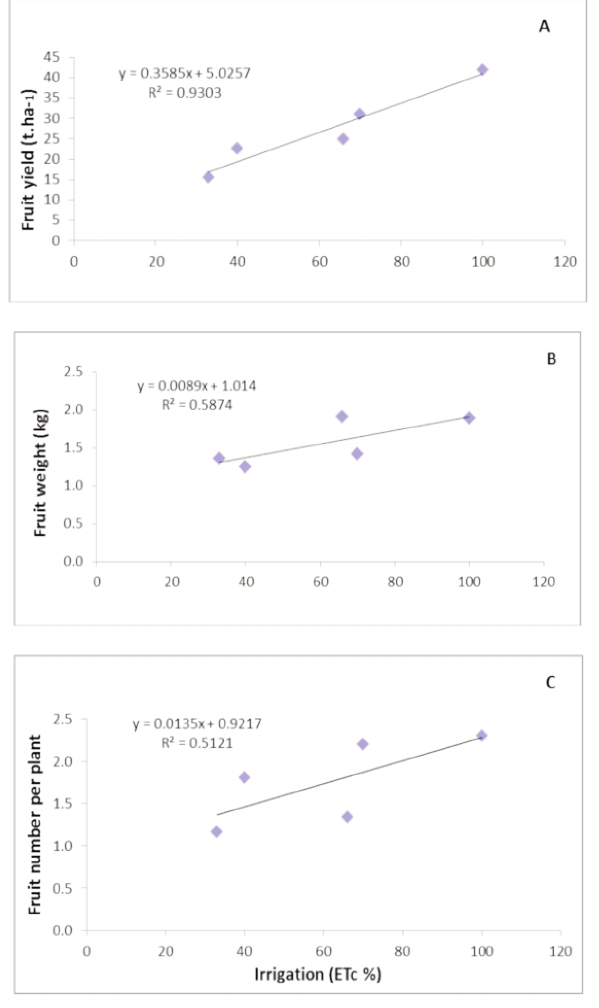
Fig. 1 - Relationship between irrigation by fruit yield (a), fruit weight (b) and fruit number per plant (c) in 2014 and 2015. Values are the mean of 3 replications/10 observa- tions each irrigation level, in two years.